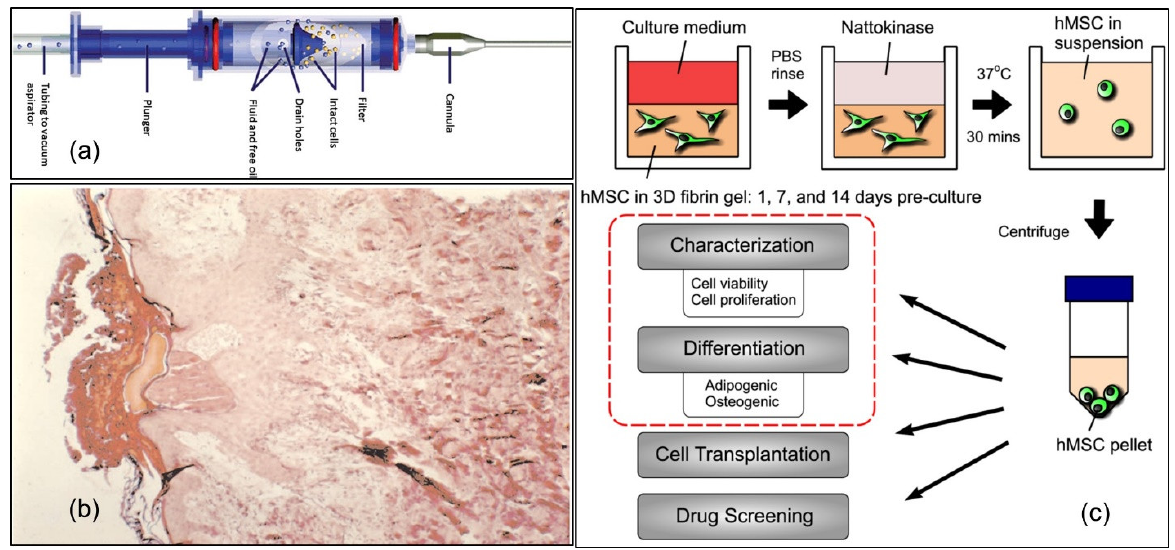
Figure 9. ( a ) Schematic of a modified syringe-based device. The device was designed to harvest small volumes of autologous adipose tissue for cosmetic surgical applications. It aspirates fat at low vacuum into a sterile chamber. Once inside, the fat cells are concentrated by filtration. Fluids and free oil are drawn into a waste canister. Reprinted/adapted with permission from Ref. [73]. 2013, Elsevier. ( b ) Biopsy taken 6 days following the application of fibrin glue suspended keratinocytes combined with allogeneic overgrafting. Histology demonstrates the initial integration of allogeneic dermal elements in the reconstituted neoskin. Reprinted/adapted with permission from Ref. [75]. 2014, Mary Ann Liebert, Inc. ( c ) Illustration depicting the methods by which MSCs were extracted from 3D fibrin gels. Reprinted/adapted with permission from Ref. [76]. 2004, Springer Nature.